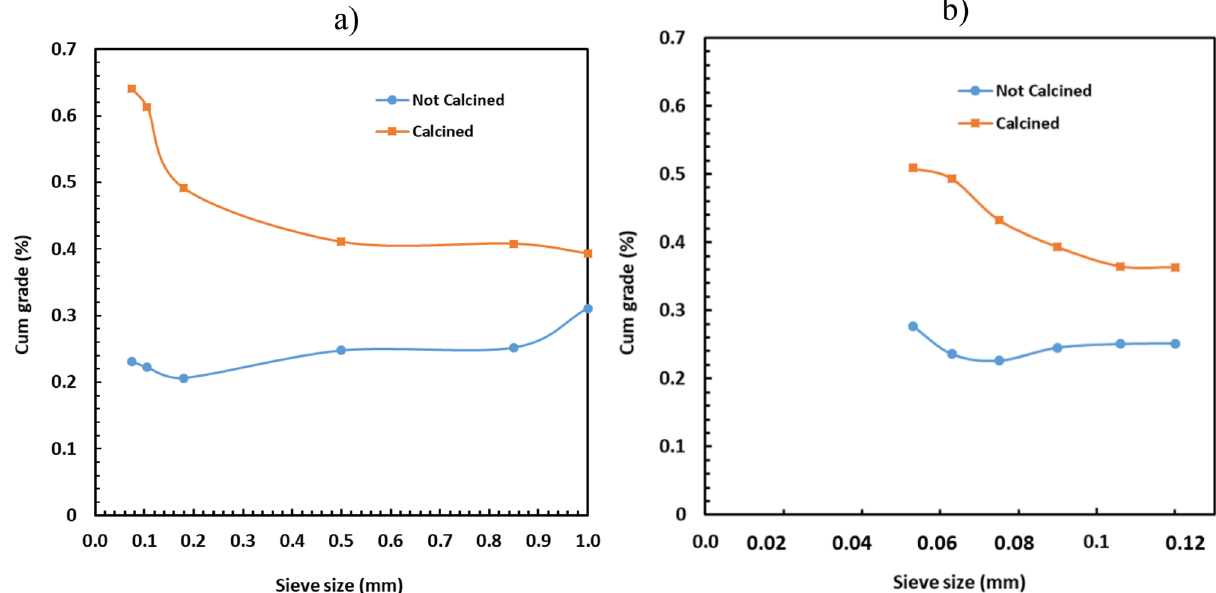
Figure 7. Influence of calcination on the cumulative grade of lithium in the case of ( a ) feed of the ball mill and ( b ) product of the ball mill.